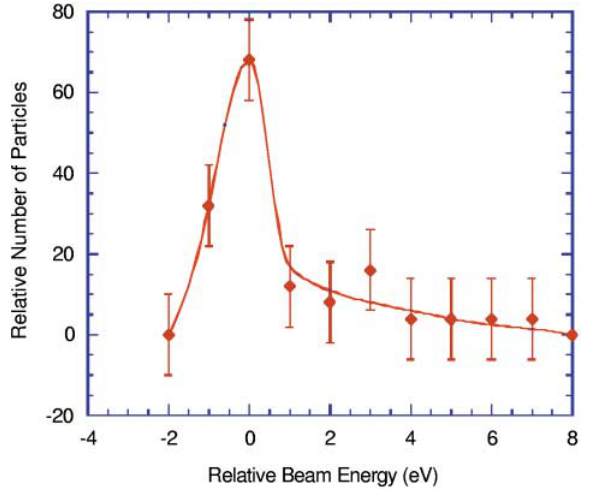
FIG. 10. (Color) Beam energy profile for a beam with energy of 2.5 keV and current of 60 mA. The rms energy width is 1.8 eV.